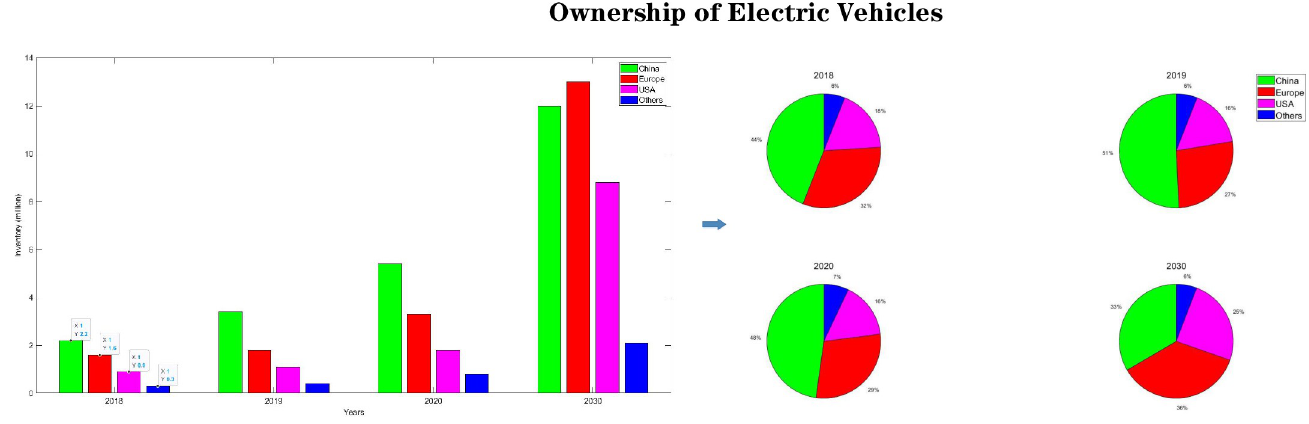
Fig 1. Global EV ownership.